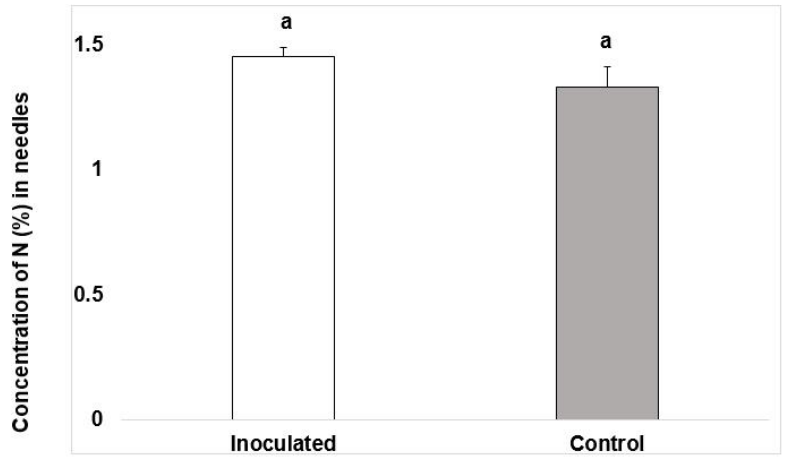
Figure 4. Total N concentration in the inoculated and control Douglas-fir seedlings needles at harvest. Data are the mean of 12 replicates. Error bars show the standard deviation. ( p =